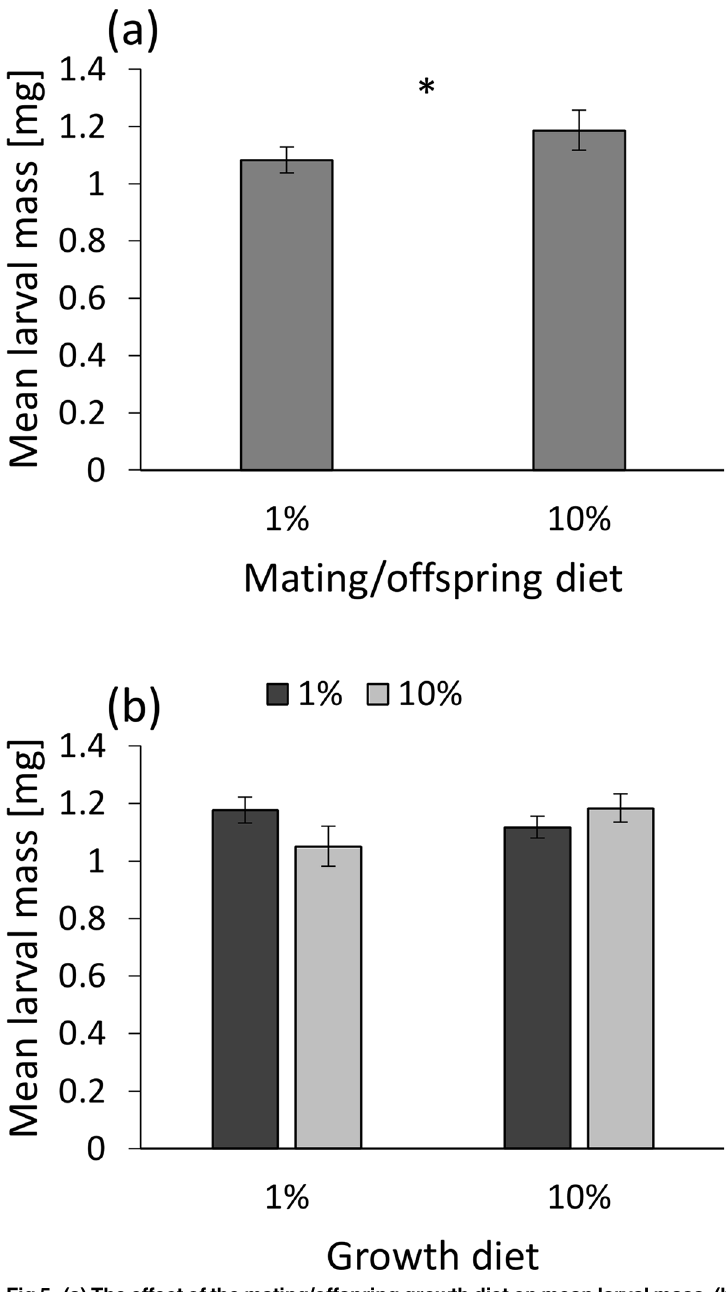
Fig 5. (a) The effect of the mating/offspring growth diet on mean larval mass. (b) The interaction between parental growth (X axis) and adult diets (left-dark and right-bright columns represent yeast- poor and yeast-rich diets, respectively) on mean larval mass. Means ± 1 SE are presented. Offspring grown under the rich-yeast diet are larger. A match between the parental growth and adult diets also leads to larger offspring. In spite of the statistical significance, groups did not differ from each other according to a Tukey's post-hoc test because of the small differences between group means and owing to the correction for multiple